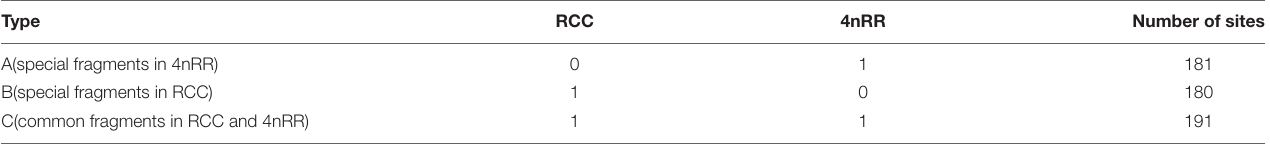
TABLE 1 | AFLP fragments that were observed in Carassius auratus (RCC) and in autotetraploid Carassius auratus (4nRR) generated by Pst I– Mse I digestions (eight selective primer